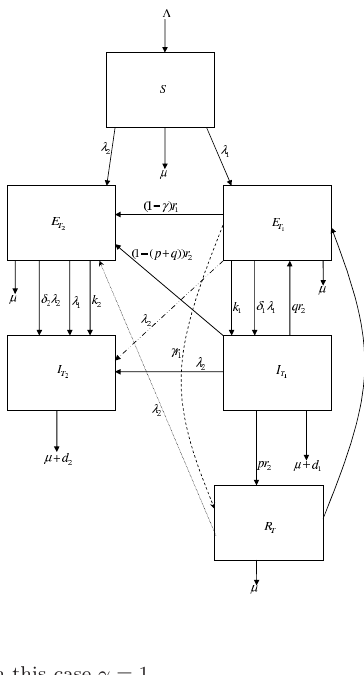
Figure 1. Structure of model. In this case γ = 1